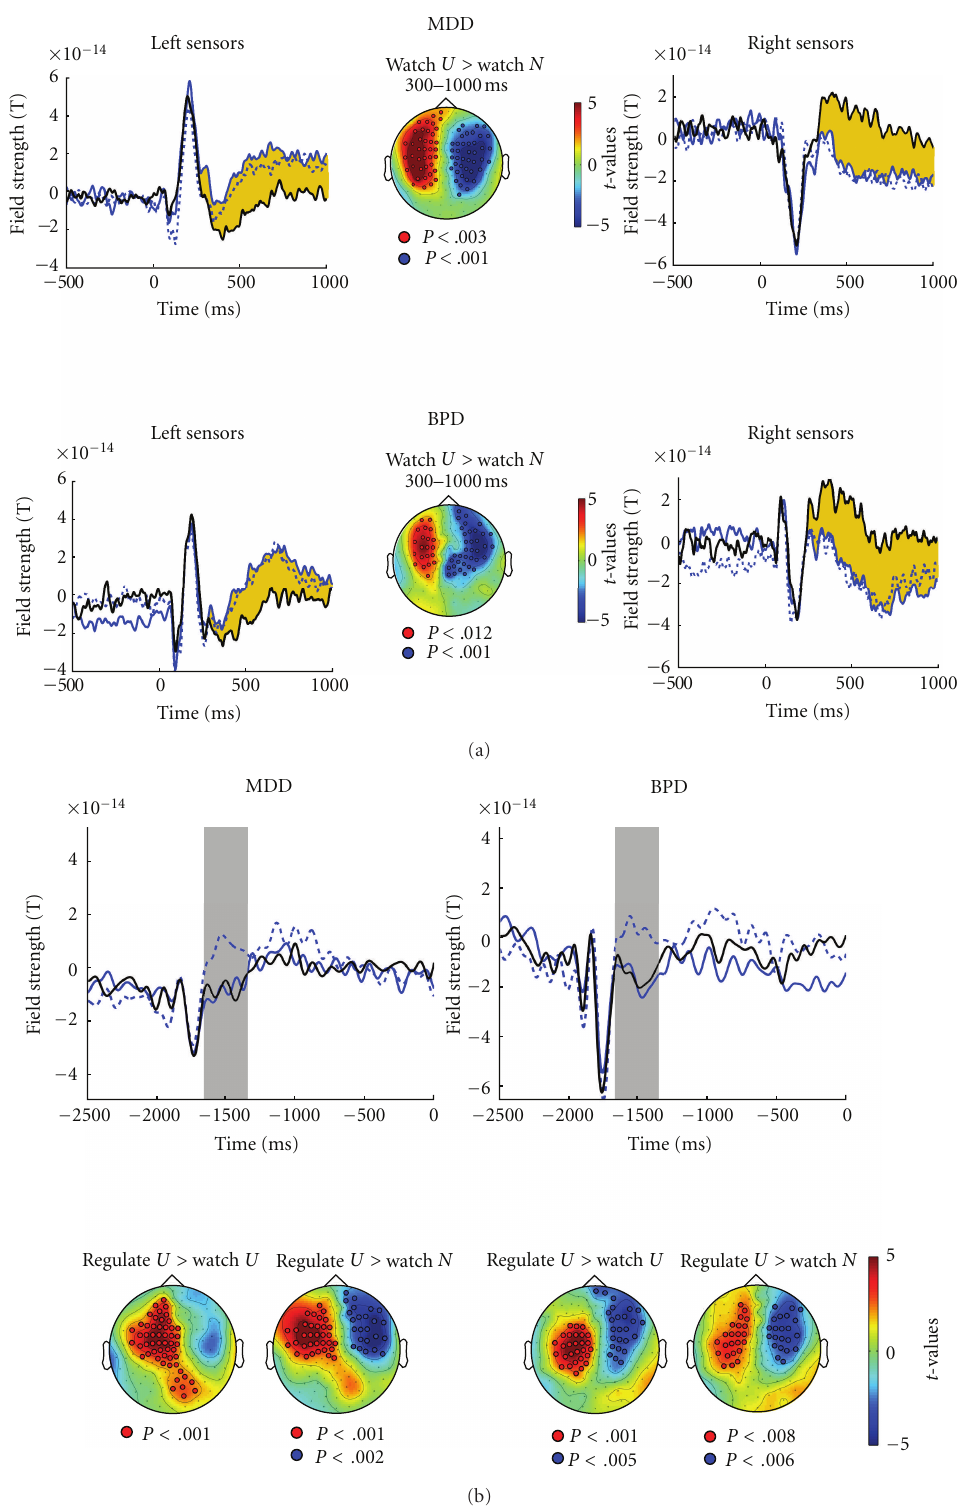
Figure 2: (a) Time course of field strength around picture onset at 0ms and sensor clusters of statistical di ff erences between conditions defining the Emotion e ff ect for MDD patients (top) and BPD patients (bottom). Line types and so forth as in Figure 1(a). (b) Time course of field strength preceding picture onset at 0ms, with cross cue onset at − 2000 ms, and sensor clusters of statistical di ff erences between conditions for MDD (left) and BPD (right) patients. Line types, gray bars, and so forth as in Figure